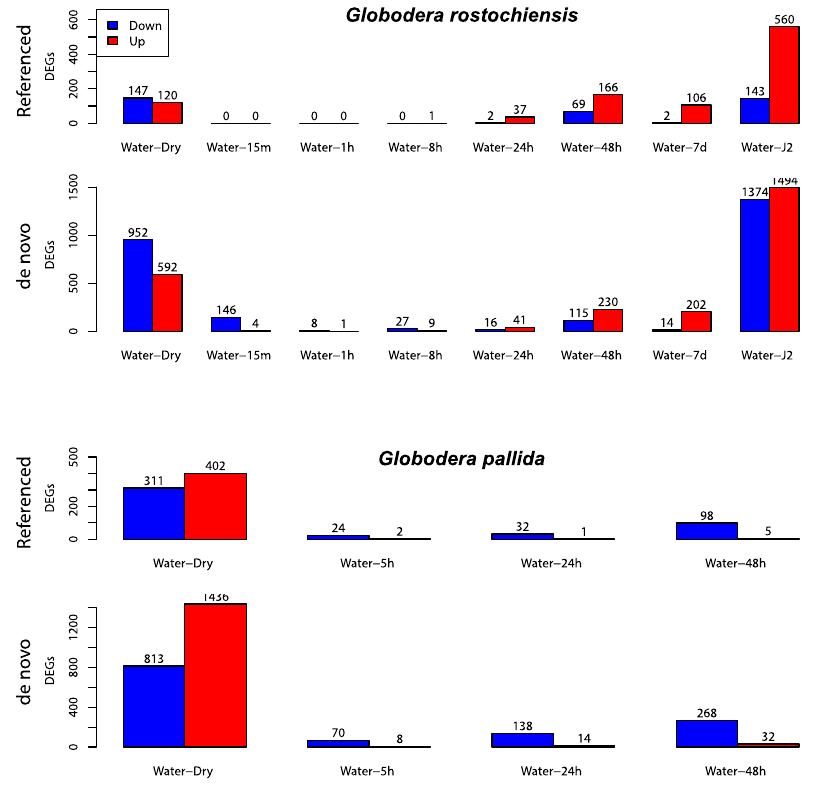
Figure 1. Pairwise counts of differentially expressed genes (DEGs) in each treatment of each transcriptome. The control treatment “water” represents hydrated cyst and time represent the soaking time in PRD/TRD after